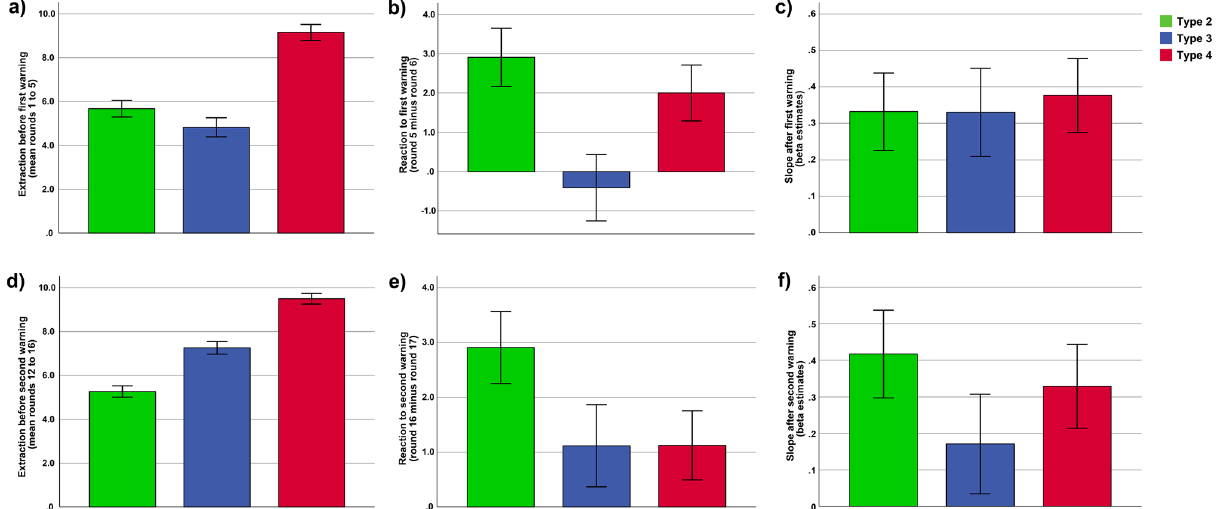
Figure 3. Extraction behaviour in the different stages of the sequential paradigm showed a characteristic pattern in the behavioural types. The bar graph in ( a ) illustrates the differences in extraction behaviour in the five rounds before the first warning (mean), which were qualified by higher extractions in type 4 compared to the two other types. The bar graph in ( b ) illustrates the differences in the reaction to the first warning, which were qualified by larger warning reactions (i.e. larger extraction differences between round 5 and round 6) in type 2 and type 4 compared to type 3. Note that positive values indicate a reduction in extraction after the warning, whereas values around zero indicate no change in extraction behaviour between the rounds before and after the warning. The bar graph in ( c ) illustrates the slopes in extraction behaviour in the rounds 6–10 following the first warning. All three behavioural types had a highly similar and positive slope, indicating a linear increase in extraction over time after the first warning. The bar graph in ( d ) illustrates the differences in extraction behaviour in the five rounds before the second warning (mean). Here type 4 demonstrated the highest extractions, type 2 the lowest extractions, with type 3 being in-between. Note that type 3 significantly increased the extraction behaviour in the rounds before the second warning (compared to the rounds before the first warning), whereas the other two types did not show such a change in extraction behaviour. The bar graph in ( e ) illustrates the differences in the reactions to second warning, which were qualified by (slightly) larger warning reactions (i.e. larger extraction differences between round 16 and round 17) in type 2 compared to the other two types. The bar graph in ( f ) illustrates the slope in extraction behaviour in the rounds 17–20 following the second warning. All three behavioural types had a similar (differences were not significant) and positive slope, indicating a linear increase in extraction over time after the second warning. Error bars depict standard errors of the